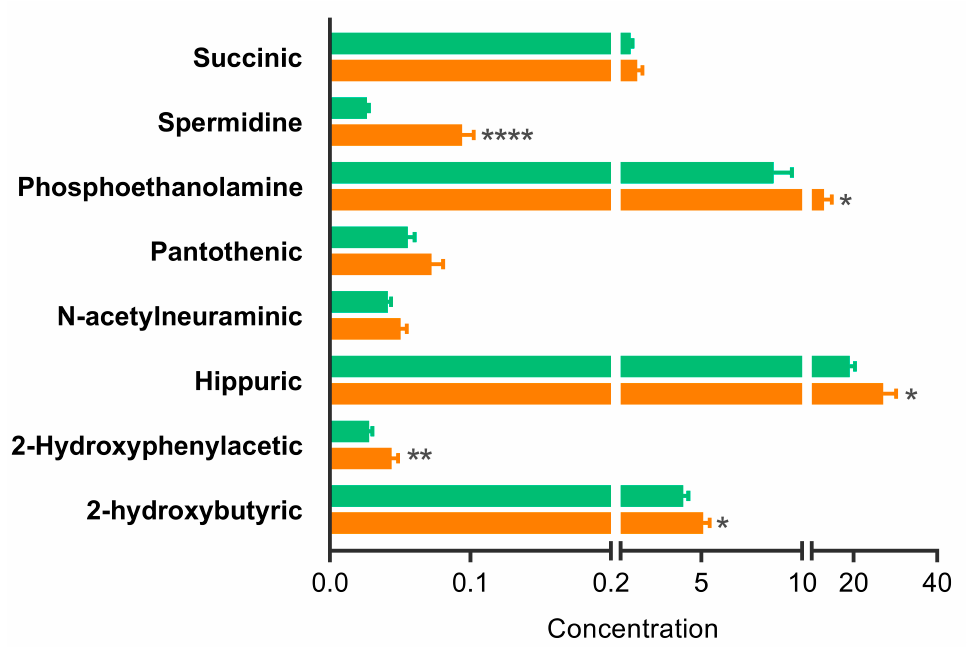
Figure 2. Differential analysis of metabolite concentrations in pre-surgery urine samples. Concentra- tion values are expressed in uM/mM Creatinine for all metabolites except phosphoethanolamine, for which the concentration value is expressed in nM/mMCreatinine. Green bars: CVS-C; Orange bars: CVS-AKI. Mann–Whitney: * p < 0.05, ** p < 0.01, **** p <